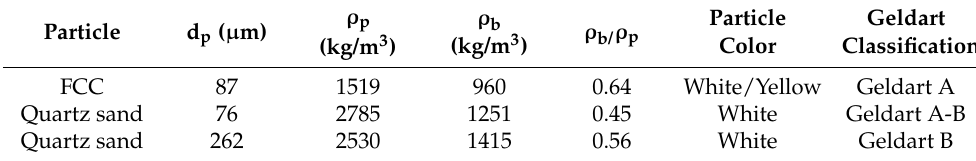
Table 1. Different experimental particle